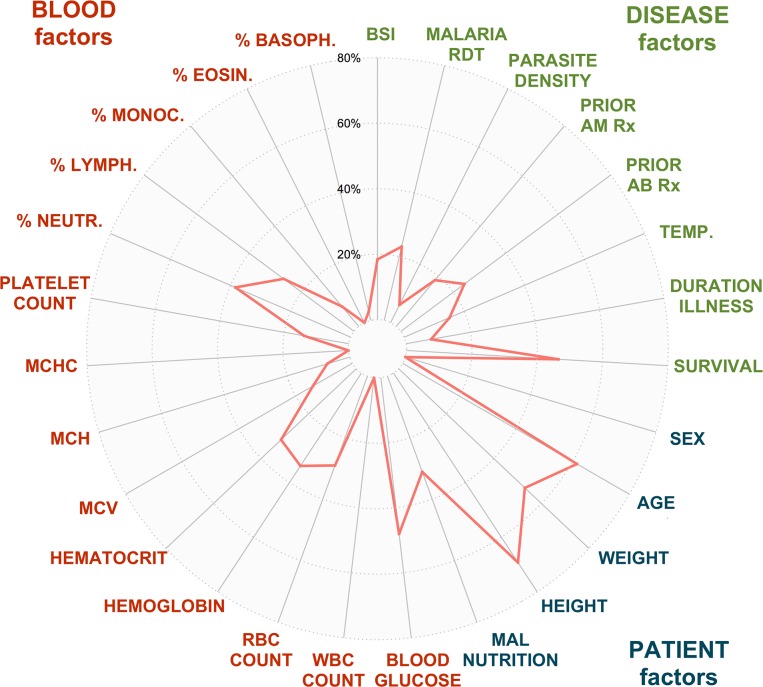
Spiderplot showing the results of the 27 regression analyses modeling the co-variance between metabolome measurements and the listed patient characteristics.The plotted validation metric Q2 allows assessing the relative impact of the patient characteristics on the metabolome. The following 27 patient variables were included in the analysis from center top in clockwise direction: BSI = confirmed or no confirmed BSI diagnosis; malaria RDT = positive or negative malaria rapid diagnostic test; parasite density = number of asexual Plasmodium parasites in the bloodstream (x103/mL); prior AB Rx = reported or no reported antibiotic treatment in the past 48 hrs; prior AM Rx = reported or no reported antimalarial treatment in the past 48 hrs; temp. = axillary temperature at time of hospital admission (°C); duration illness = duration illness prior to hospital admission (days); survival = clinical outcome survival or no survival; sex = male or female; age = age expressed in months; weight = weight expressed in kg; height = height expressed in cm; malnutrition = presence or absence of severe malnutrition defined as weight for height score < 70% according to national guidelines or report of kwashiorkor; blood glucose = blood glucose level (mg/dL); WBC = white blood cell count in blood (x103/μl); RBC = red blood cell count in blood (x106/μl); hemoglobin = blood hemoglobin level (g/dL); hematocrit = blood hematocrit (%); MCV = mean corpuscular volume (fL); MCH = mean corpuscular hemoglobin (pg); MCHC = mean corpuscular hemoglobin concentration (g/dl); platelet count = platelet blood count (x103/μL); % neutr. = neutrophils as % of total WBC; % lymph. = lymphocytes as % of total WBC; % monoc. = monocytes as % of total WBC; % eosin. = eosinophils as % of total WBC; % basoph. = basophils as % of total WBC.